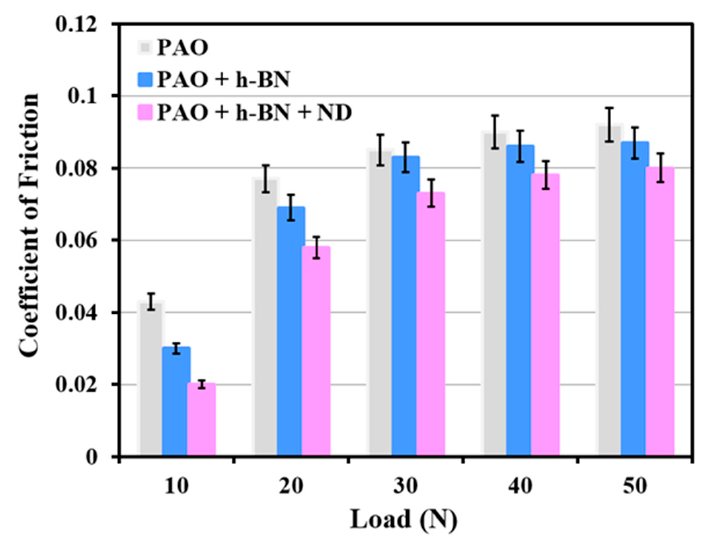
Figure 15. Coefficient of friction of steel–aluminium tribopair with PAO base oil, PAO + h-BN and PAO + h-BN + ND nanolubricants, with increase in applied load from 10 N to 50 N.